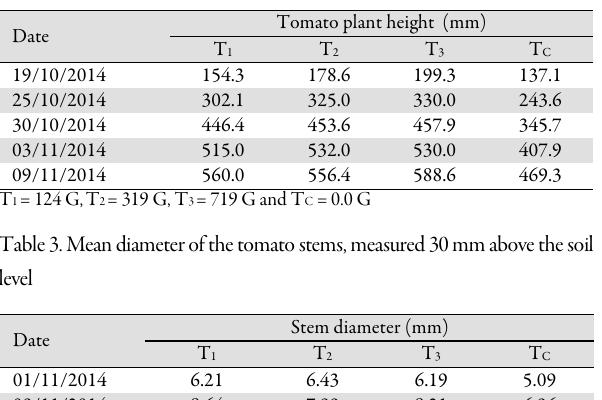
Table 2. Mean height of the tomato plants recorded during the vegetative growth